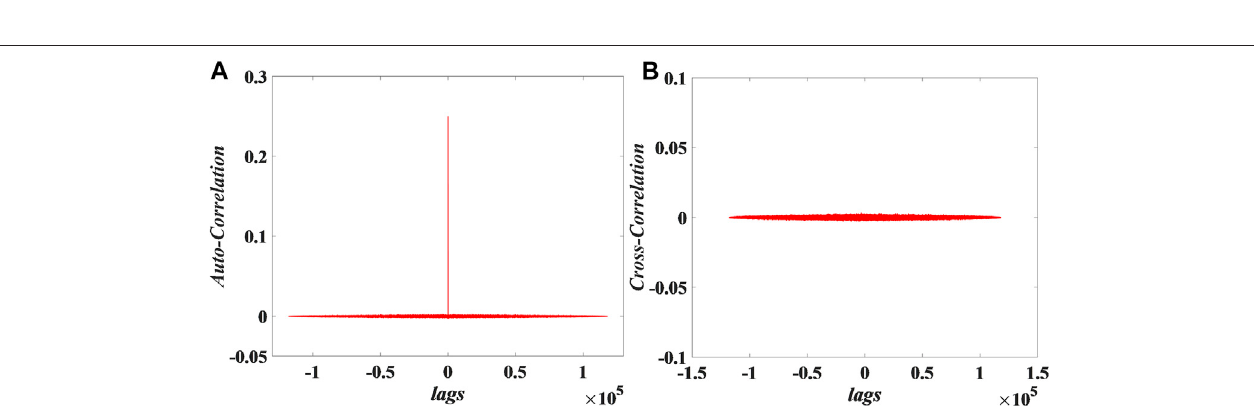
Frontiers in Physics |